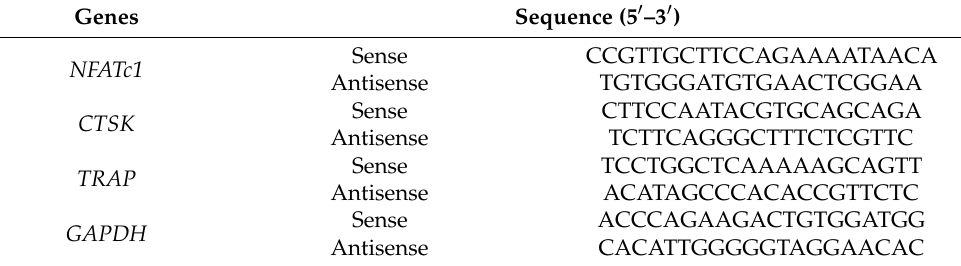
Table 1. Gene sequences of the mouse primer used in the